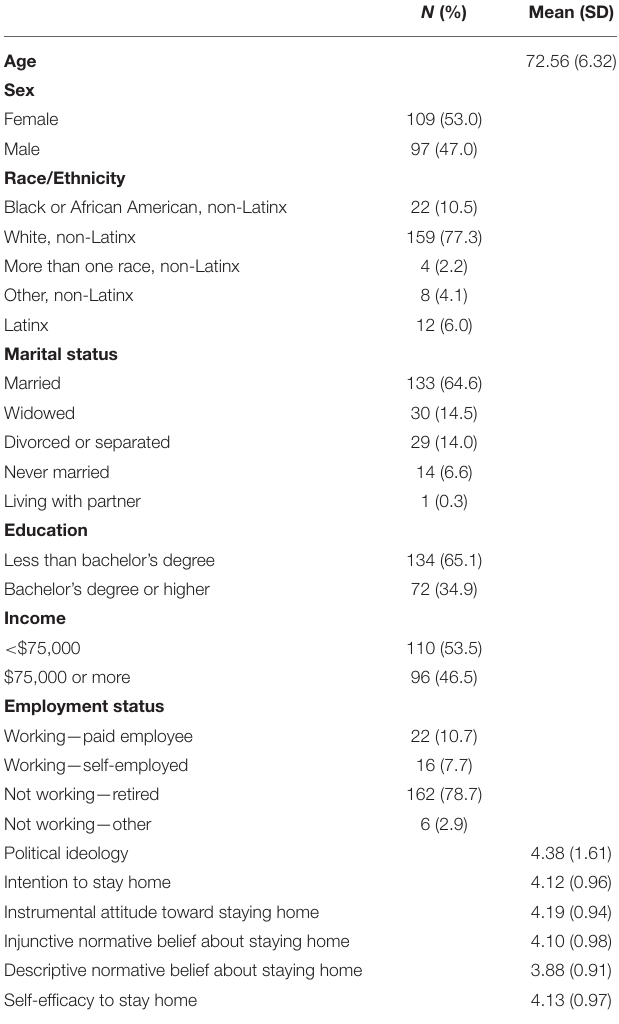
TABLE 1 | Sample characteristics (Weighted N =